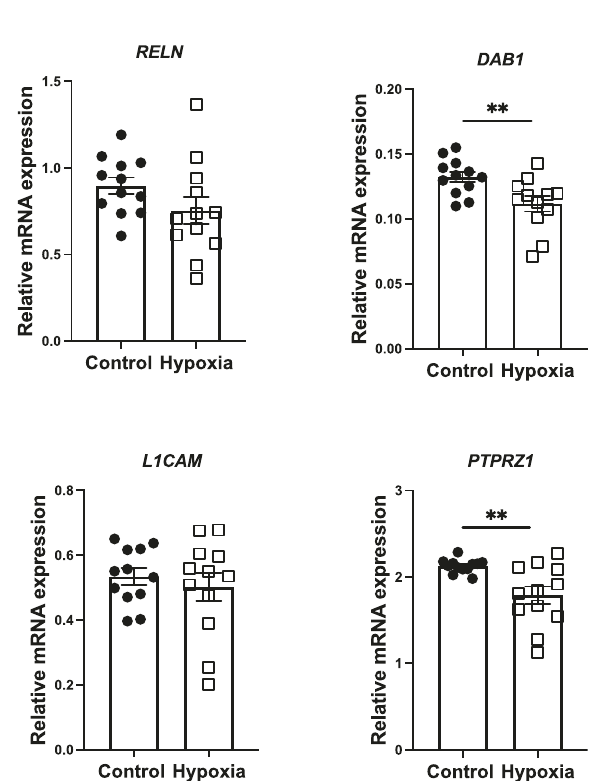
Fig. 2 Prenatal hypoxia reduces the expression of receptors governing lateral DA neuron migration of early DA neurons. Hypoxia reduced the expression of the receptors DAB1 and PTPRZ1. However, hypoxia had no effect on the expression of their respective ligands Reelin and L1CAM. (Control, n = 12, Hypoxia, n = 12; data are shown as mean ± SEM; Group differences are indicated ** P <